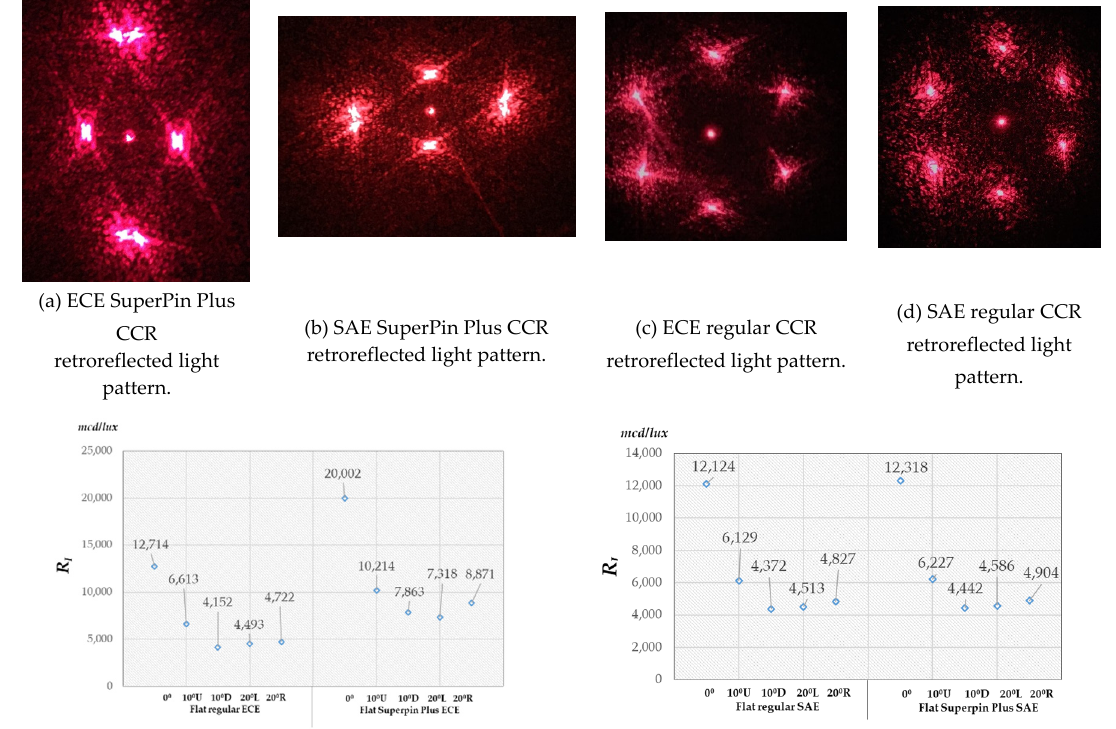
Figure 7. Experimental setup for testing samples (flat and curve).